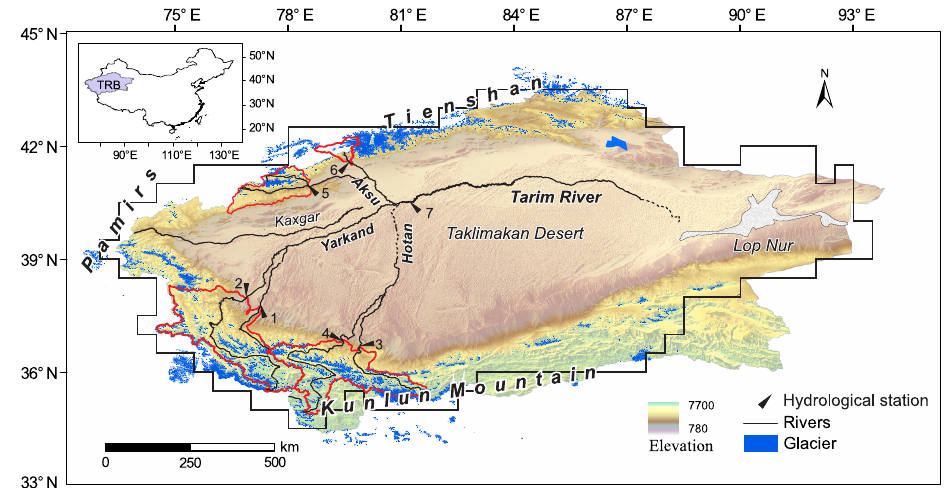
Figure 1. The major rivers and the glacier distribution in the Tarim Basin. The upper Yarkand River catchment is defined by hydrological gauges 1 (JK) and 2 (KQ), the upper Hotan River catchment is defined by hydrological gauges 3 (TGZLK) and 4 (WLWT), and the upper Aksu River catchment is defined by hydrological gauges 5 (SLGLK) and 6 (XHL). The upper Tarim Basin is defined by hydrological gauge 7